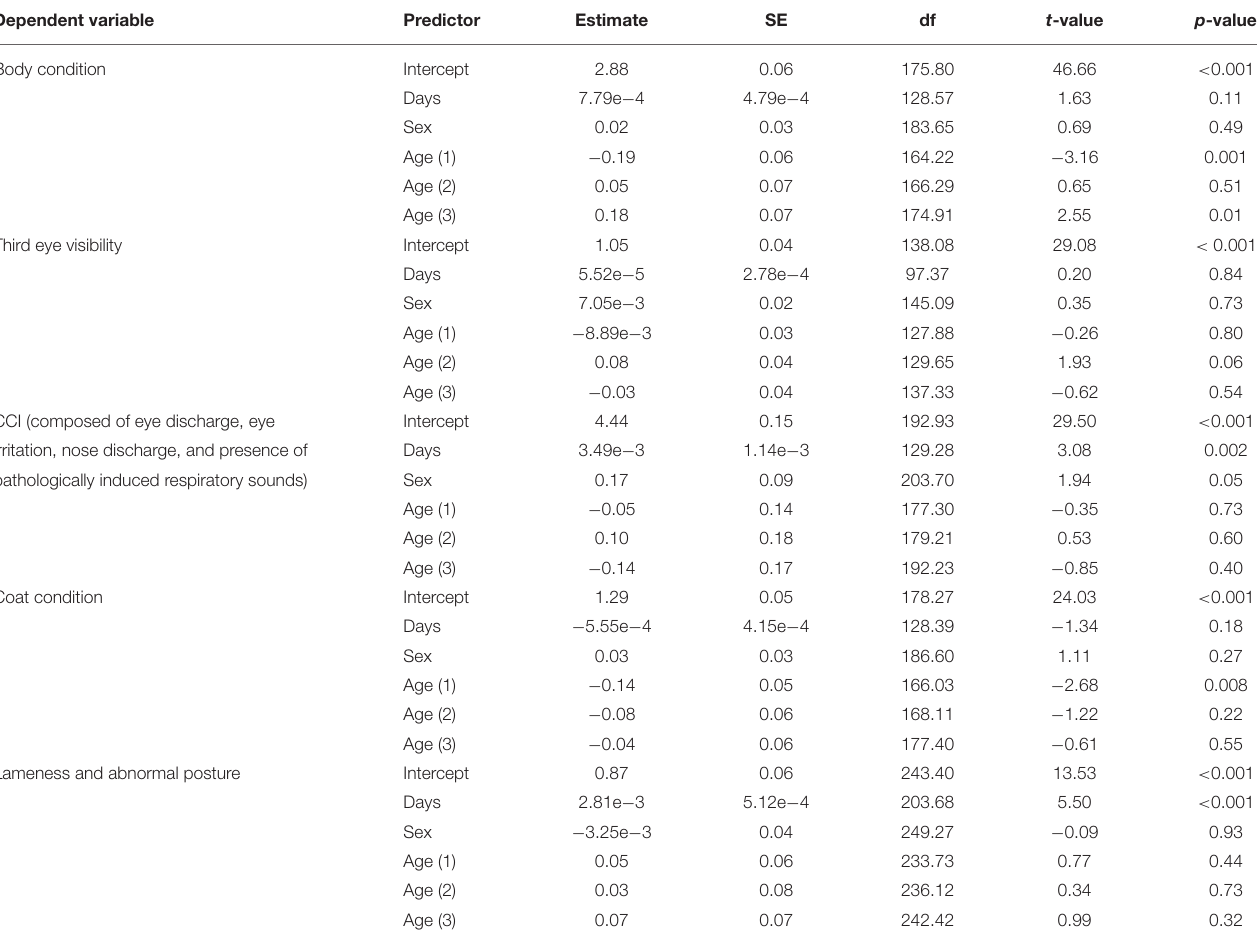
TABLE 7 | Fixed effect estimates for each of the analyzed